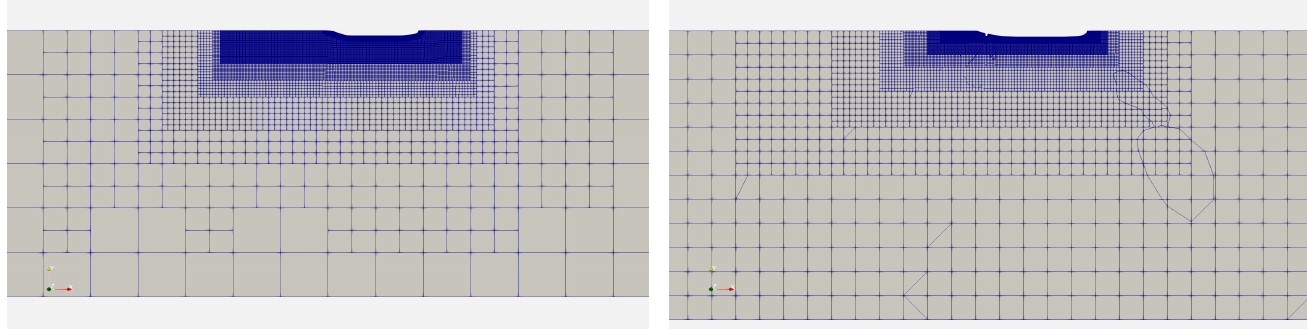
Figure 5. Slices showing mesh refinement for fine grid around SUBOFF (left hand side) and Type 209/1300 (right hand side) submarine with 4,500,437 and 9,145,512 cells